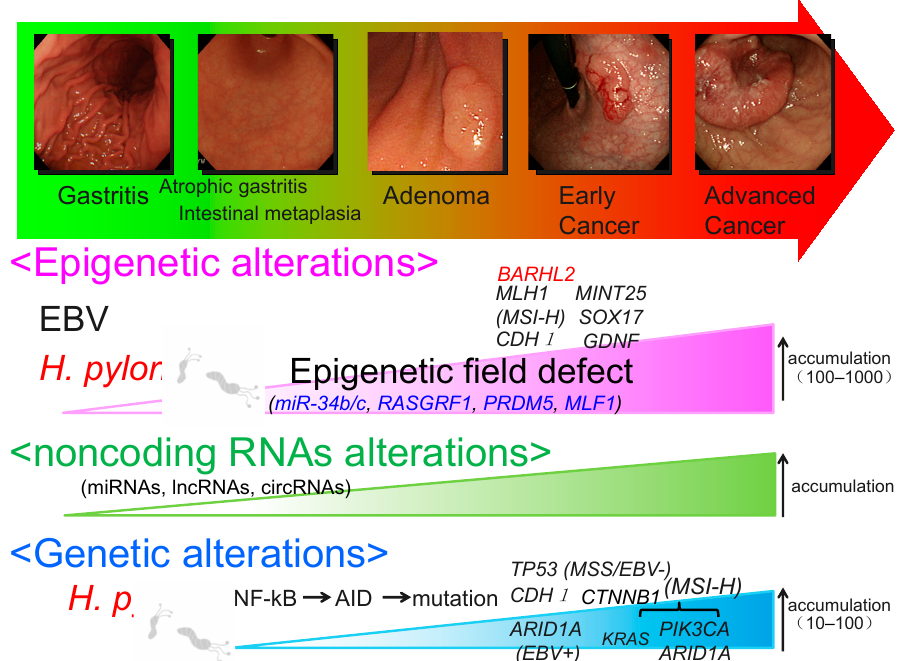
Figure 1. Molecular alterations in gastric carcinogenesis. The model for gastric carcinogenesis is presented based on alterations in genome, epigenome, and noncoding RNAs. Methylation of the genes in blue appears to be involved in an epigenetic field defect. H. pylori : Helicobacter pylori ; MSI-H: High-frequency microsatellite instability; EBV: Epstein–Barr virus.